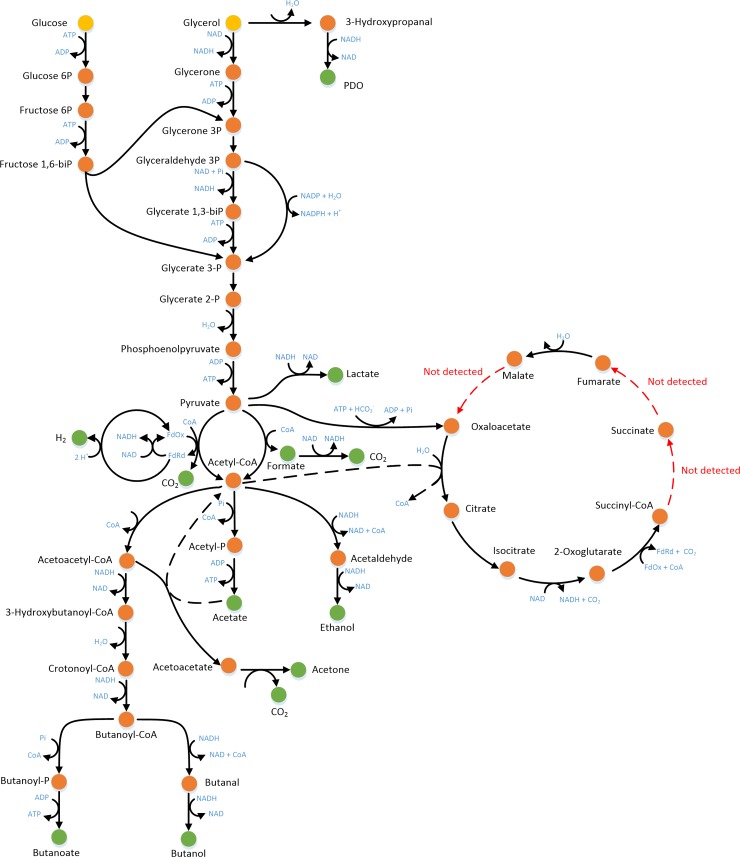
Anaerobic metabolism of glycerol by Clostridium butyricum of the iCbu641 GSM model.Notation: substrates (yellow dots), intracellular metabolites (orange dots), extracellular products (green dots) [6].